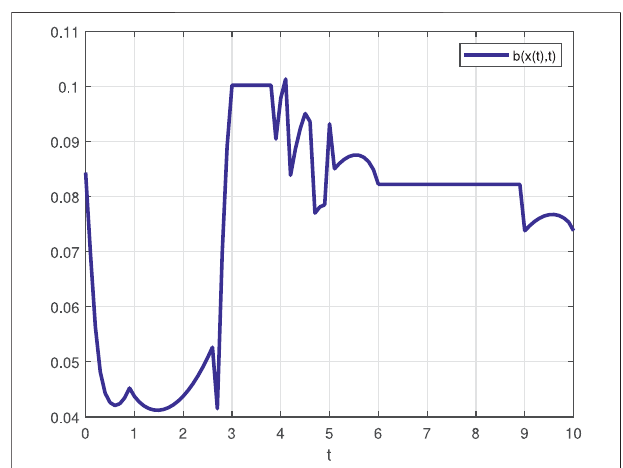
FIGURE 3 | Control barrier function b ( x , t ) for STL task speci fi cation φ 1 ( 27 ).The17non-differentiablepointsarecorrespondstotimestepswith J ( x , t ) containing two members for which the control law ( 23 ) still